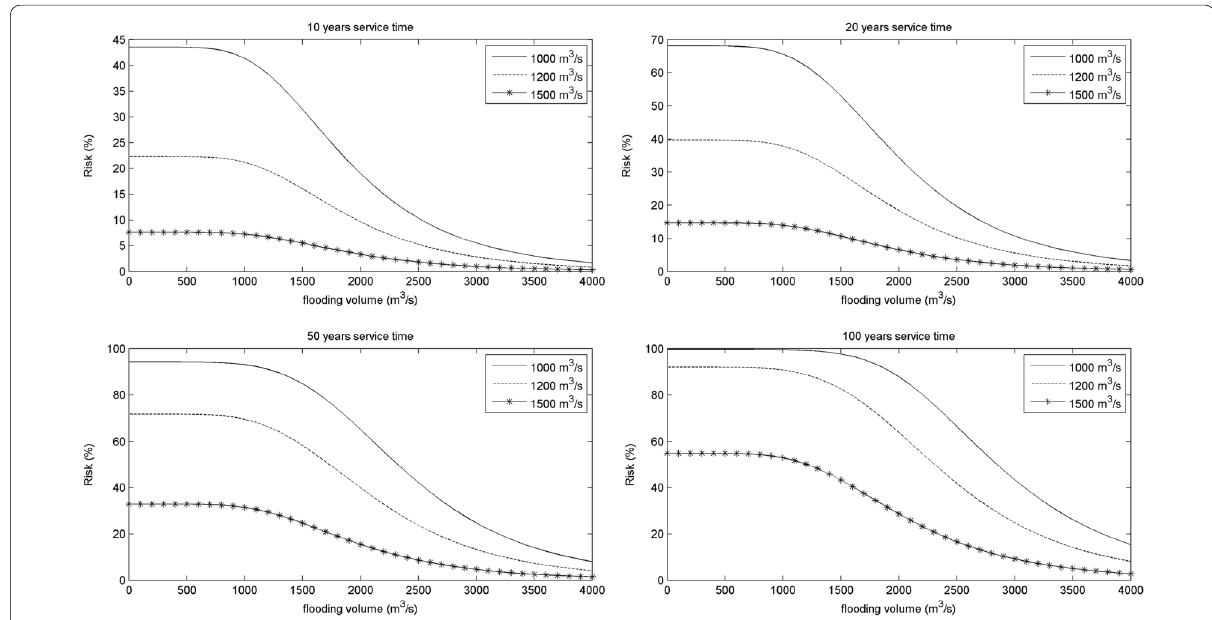
Fig. 12 Bivariate flooding risk under different flooding peak-volume scenarios